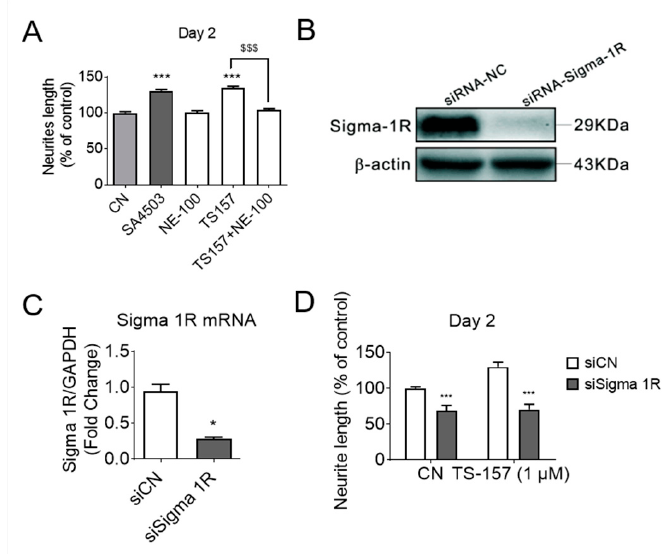
Figure 4. ( A ) The σ -1 antagonist NE-100 (1 µ M) attenuates the effect of TS-157 (1 µ M) on promoting neurite outgrowth; ( B , C ) σ -1 siRNA interferes with receptor expression; ( D ) σ -1 siRNA reverses the effect of TS-157 on extending neurite length. Data obtained are expressed as mean ± SEM, n = 12 or 3. Statistically significant differences: * p < 0.05, *** p < 0.001 vs. vehicle; $$$ p < 0.001 vs. ‘TS-157 + NE-100’ (one-way or two-way ANOVA followed by Bonferroni test).